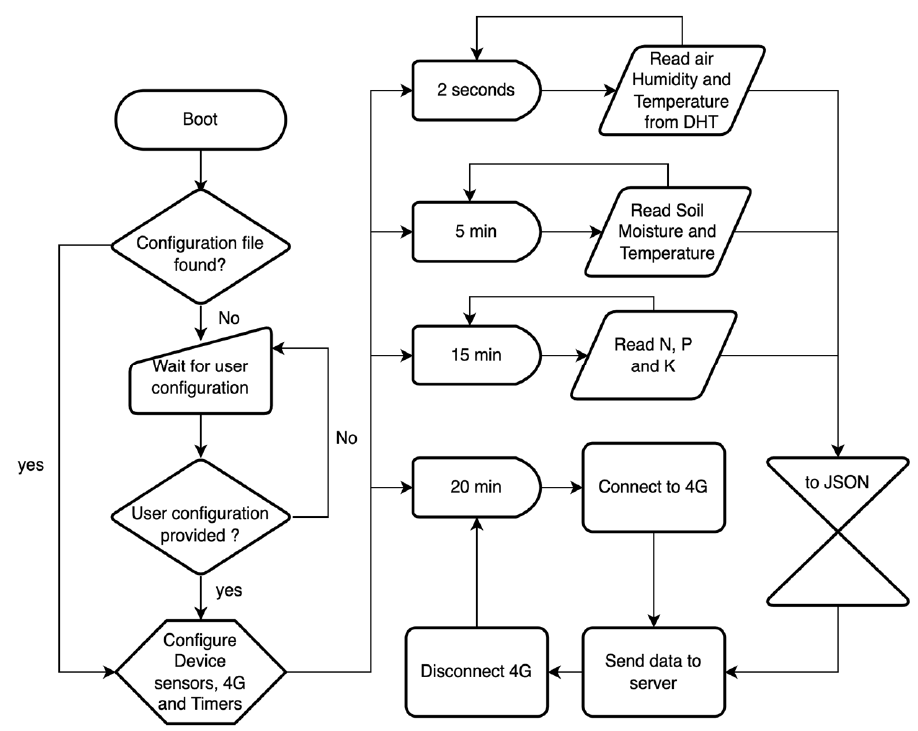
Figure 6. Flowchart of microcontroller embedded software.